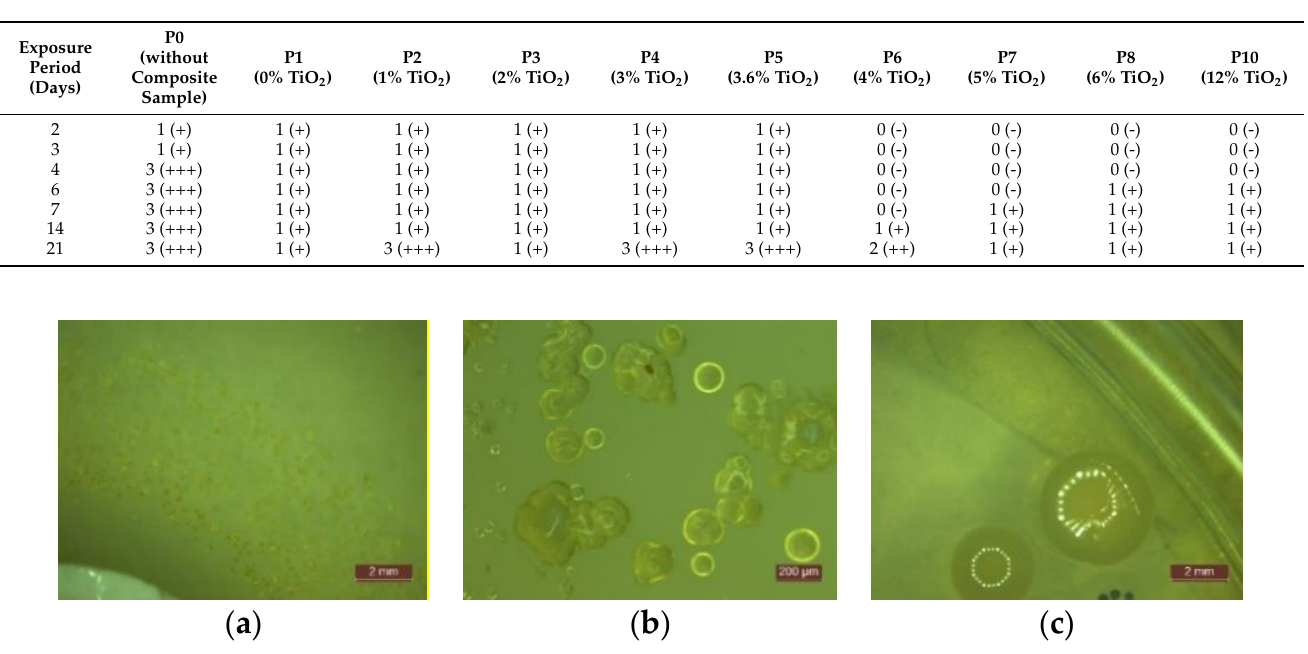
( d ) Figure 4. Microscopic examination of the behavior of samples exposed to Pseudomonas Aeruginosa : ( a ) The presence of biological material on the surface of the composite specimen at the time of sowing (1:2 mm); ( b ) Identification of the inhibition halo zone (1:2 mm); ( c ) Growth of colonies (1:500 µ m); ( d ) Detail growth of colonies (1:500 µ m).